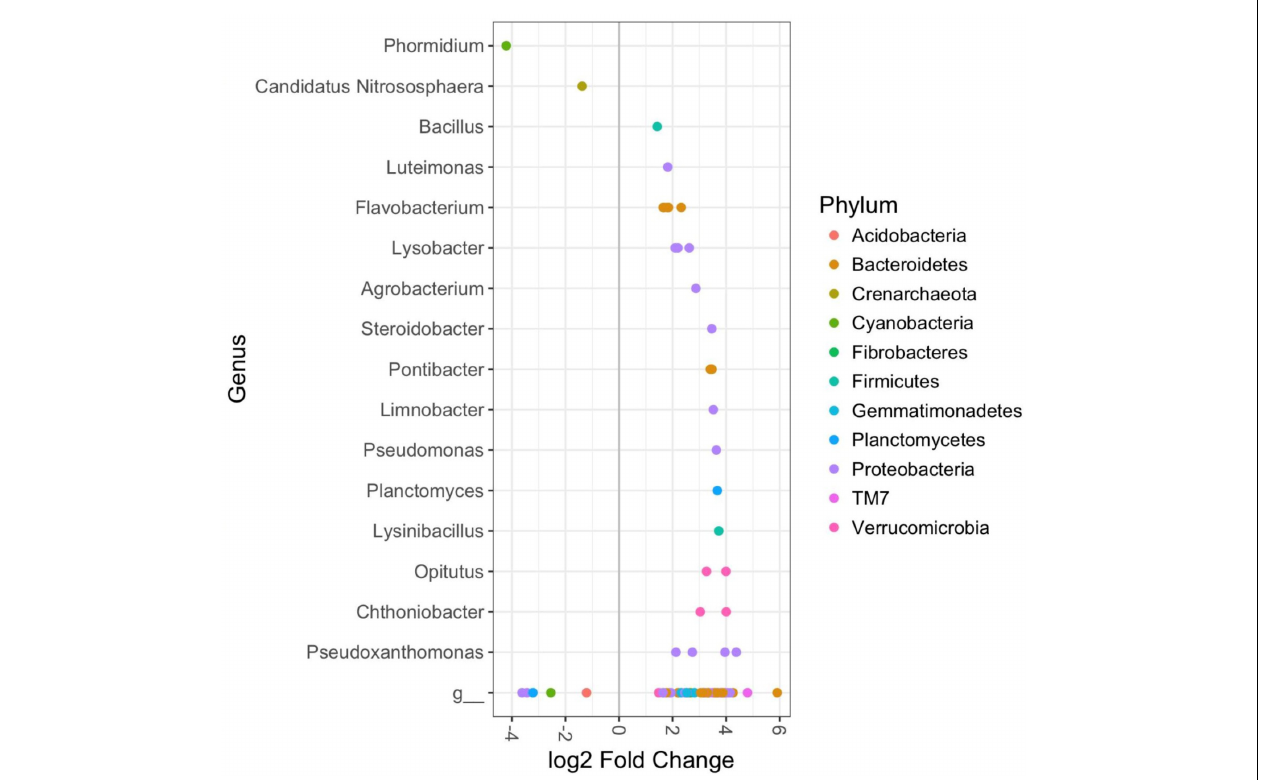
FIGURE 4 | DESeq2 analysis results indicating the fold-change of bacterial genera in rhizosphere soil bacterial communities of cabbages in the Chicken Manure fertilizer treatment relative to control cabbages at 12 weeks ( p < 0.01). Includes both aphid infested and uninfested plants as there were no significant effects of the aphids. “g” Represents taxa unclassified at the genus